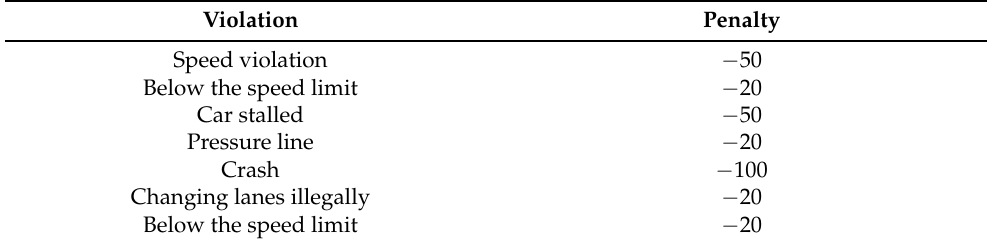
Table 6. Penalty points for driving